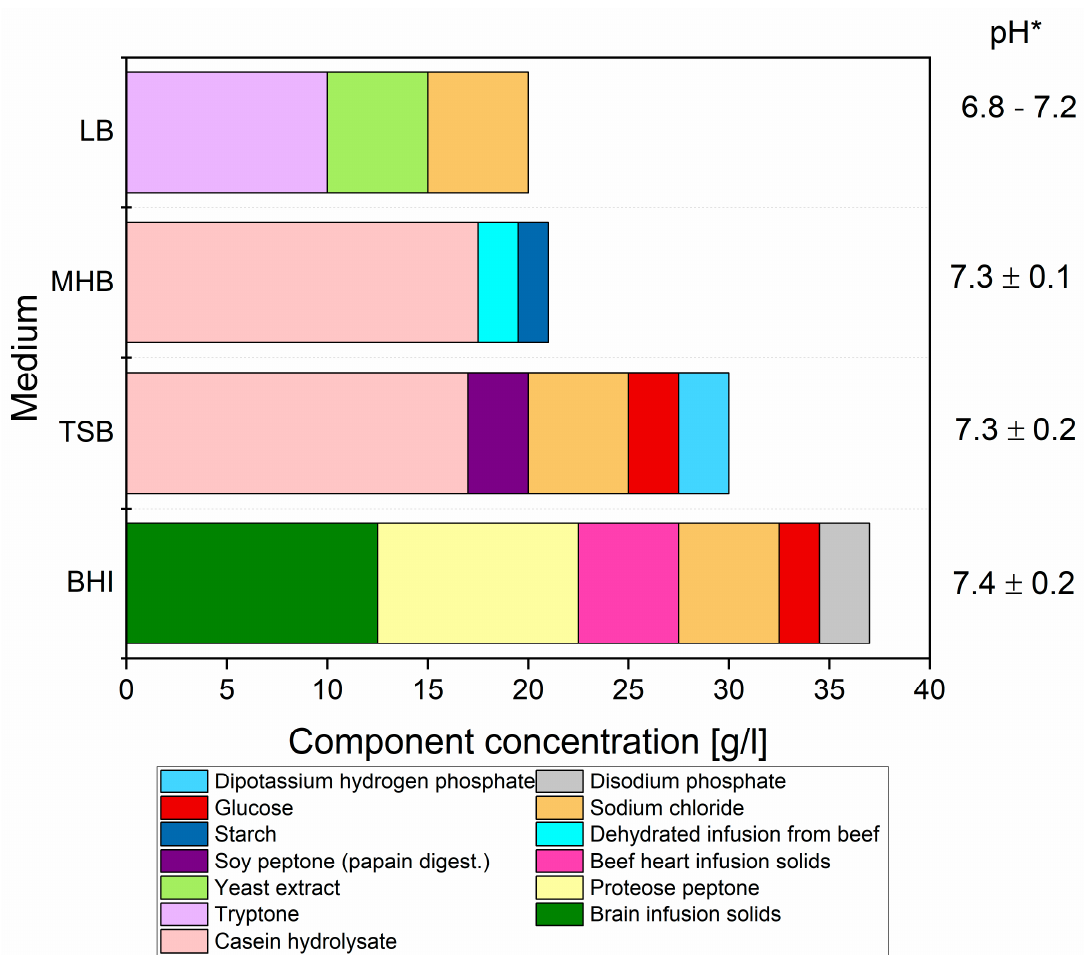
Figure 1. Concentration (g/L) of components in complexed media used for antibacterial metal activity testing. *—pH according to manufacturer.